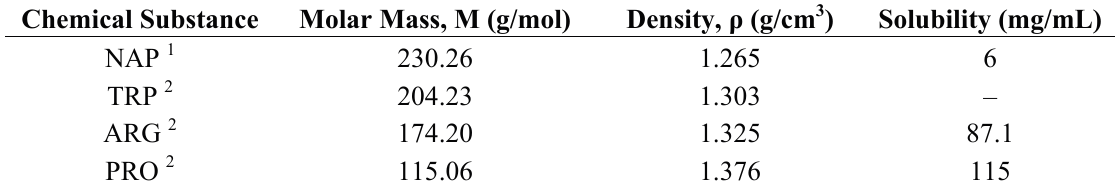
Table 1. Molar mass, density and solubility of the raw materials. NAP, naproxen; TRP, tryptophan; ARG, arginine; PRO, proline. Chemical